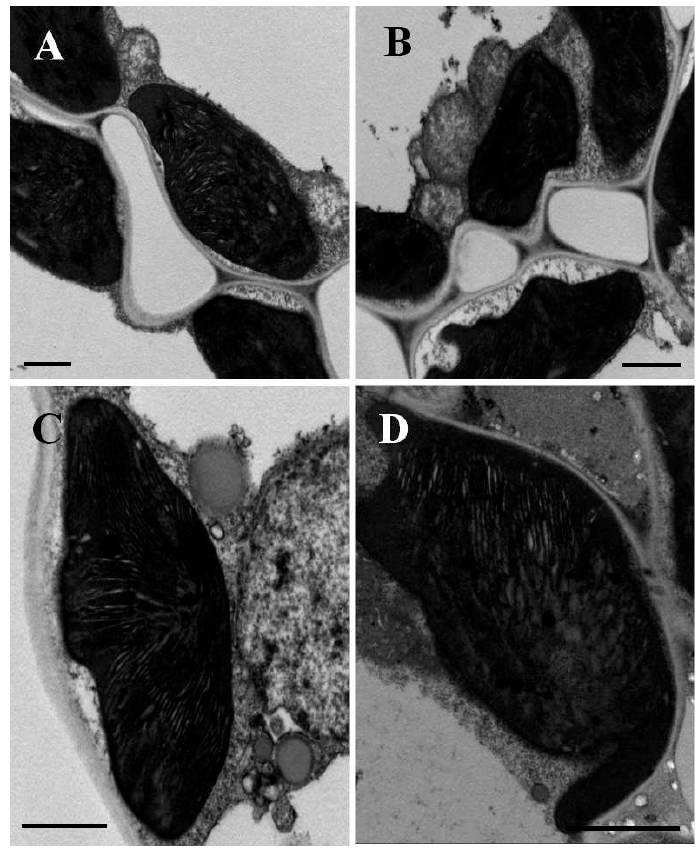
Figure 5. Electron microscope images of the mutant ygl9311 and the wild ‐ type plant at seedling stage. ( A , B ) Mesophyll cells of the wild type and ygl9311 , respectively. ( C , D ) Chloroplasts of the wild type and ygl9311 , respectively. Scale bar equals 1 μ m.